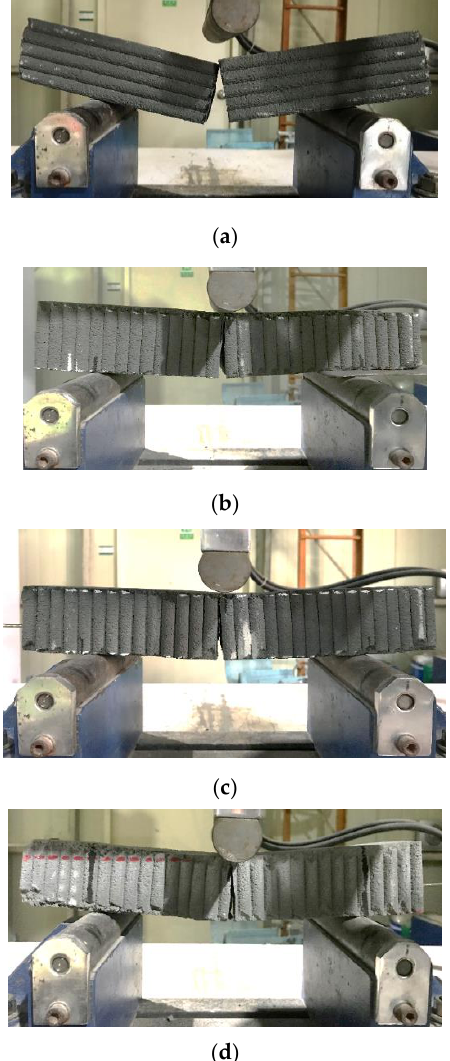
Figure 20. Flexural tensile failure patterns of mortar samples under loading directions I and III. ( a ) Specimen S1 (Loading direction I); ( b ) Specimen S2–300 (Loading direction III); ( c ) Specimen S3–40 (Loading direction III); ( d ) Specimen S4–20 (Loading direction